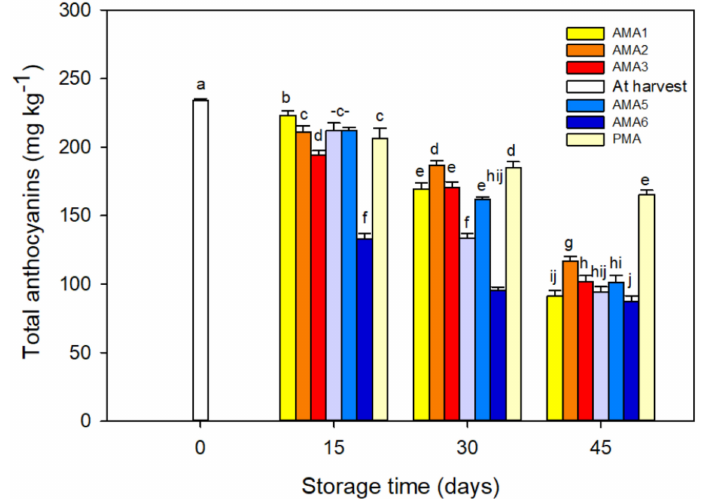
Figure 2. E ff ect of di ff erent active-MAP and passive-MAP conditions on total anthocyanins (TAC) in the kernel’s skin of fresh in-hull pistachios stored for 45 days at 4 ± 1 ◦ C and 90 ± 5% R.H. Means followed by the same letter for a parameter, are not significantly di ff erent according to the LSD ( p ≤ 0.05). Vertical bars indicate the standard errors of four